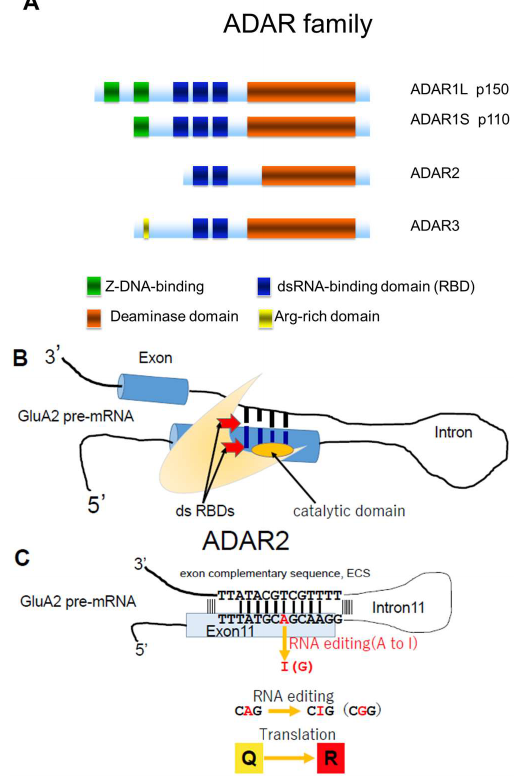
Figure 2. Adenosine deaminase acting on RNA (ADAR) structure and RNA editing. ( A ) Three members of the ADAR family. ADAR1 has two isoforms (p150 and p110). ADAR1p110 exists in the nucleus and ADAR1p150 exists in both the nucleus and the cytoplasm. ADAR2 is primarily localized in the nucleus of brain and spinal cord and catalyzes A-to-I conversion at the GluA2 glutamine/arginine (Q/R) site. Z-DNA-binding domain (green), RBD; double strand RNA (dsRNA) binding domain (blue), deaminase domain (orange), and arginine-rich domain (yellow); ( B ) ADAR2 has a double-stranded (ds) RNA binding domain (RBD; red) and a deaminase domain (orange); ( C ) dsRNA is formed at the distal end of exon 11, which includes the coding sequence for the Q/R site and the exon complementary sequence (ECS) in intron 11 of GluA2 pre-mRNA. ADAR2 catalyzes conversion of adenosine to inosine (A-to-I RNA editing) in the dsRNA structure in both coding and non-coding regions of various transcripts. The adenosine at the Q/R site of GluA2 pre-mRNA is converted to inosine (A-to-I conversion), the genomic CAG (codon for Q) is converted to CIG in mRNA, and CIG is read as CGG, which is a codon for R during